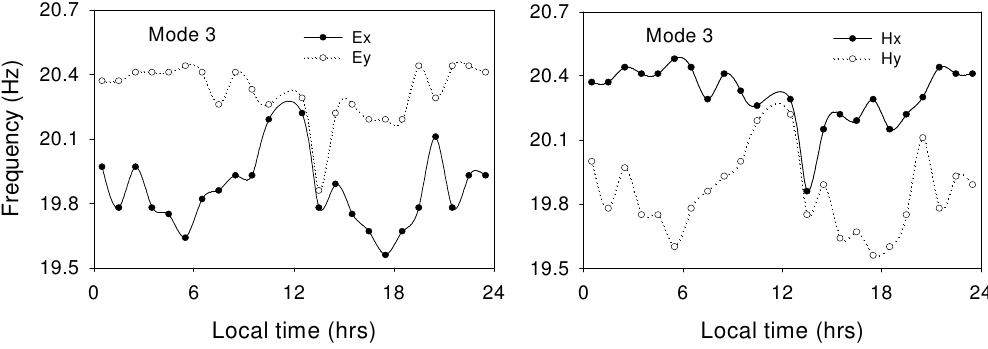
Fig. 4. The diurnal variations of the third Schumann resonance mode frequency, showing the frequency variation is not in the same phase for different components. However, different components in the same polarization show a similar